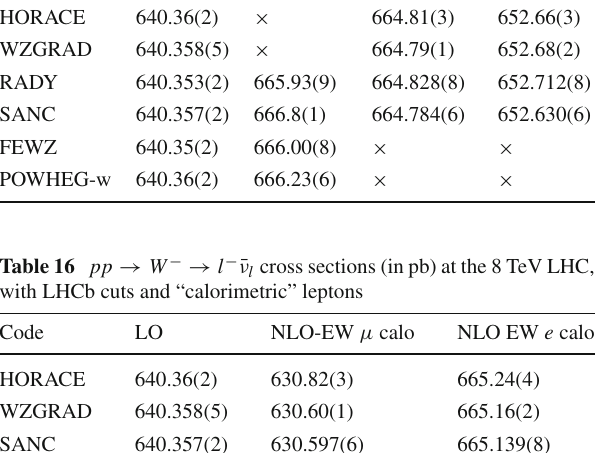
Table 15 pp → W − → l − ¯ ν l cross sections (in pb) at the 8 TeV LHC, with LHCb cuts and bare leptons